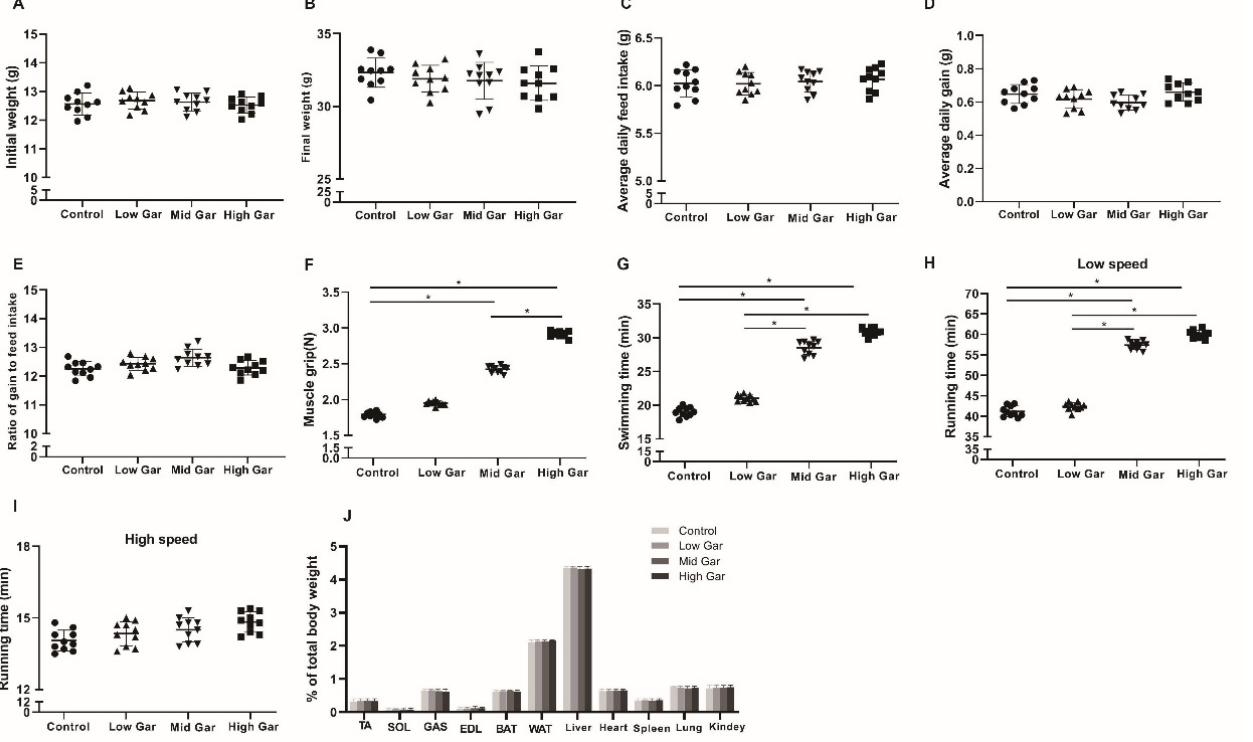
Figure 1. Effects of dietary garcinol on the Initial weight ( A ), Final weight ( B ), Average daily feed intake ( C ), Average daily gain ( D ), Ratio of gain to feed intake ( E ), Muscle grip ( F ), Swimming time ( G ), low ‐ speed running time ( H ), high ‐ speed running time ( I ) and the tissues weight ( J ) in mice fed 0–500 mg/kg garcinol for 12 weeks. Data are shown as the mean ± SE, n = 10. * Different from the control group, p < 0.05.